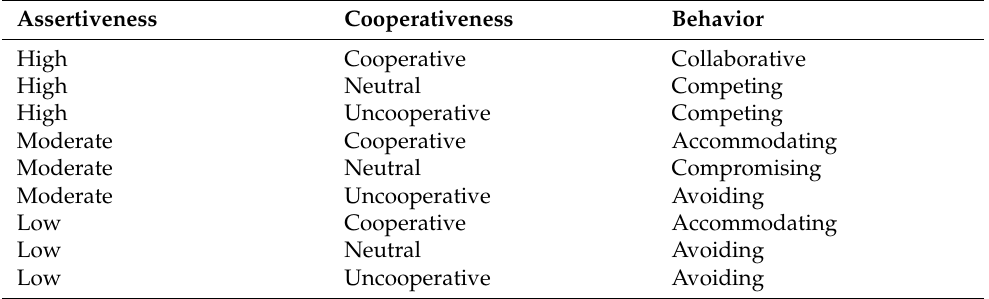
Table 1. Behavior